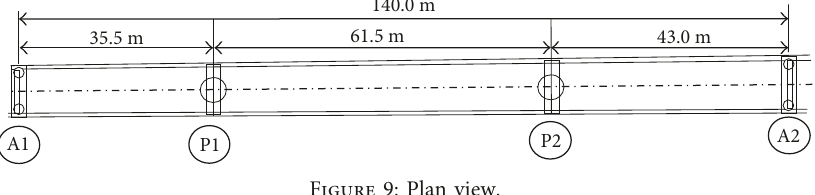
Figure 8: Longitudinal profile.